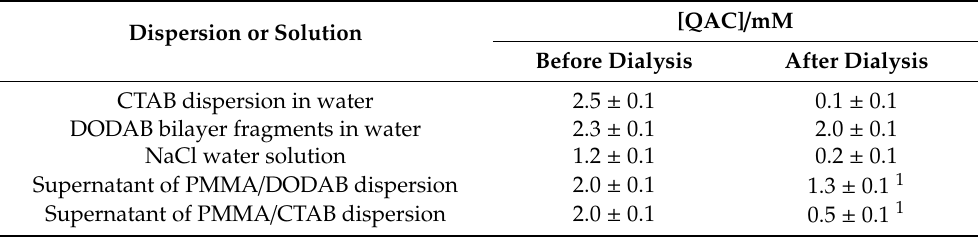
Table 5. Determination of QAC concentration [QAC] in PMMA / QAC NPs from halide microtitration in the supernatants of PMMA / DODAB and PMMA / CTAB NP water dispersions before and after dialysis. The PMMA / QAC dispersions were prepared in 2.0 mM QAC. The controls for the dialysis were QAC dispersions in water and 1 mM NaCl